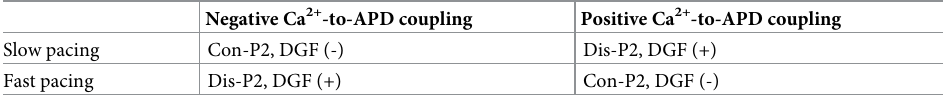
Table 1. Links between Ca 2+ -to-APD coupling, Ca 2+ release patterns, and DGF for the detailed ventricular cell model. The sign in parenthesis is the sign of